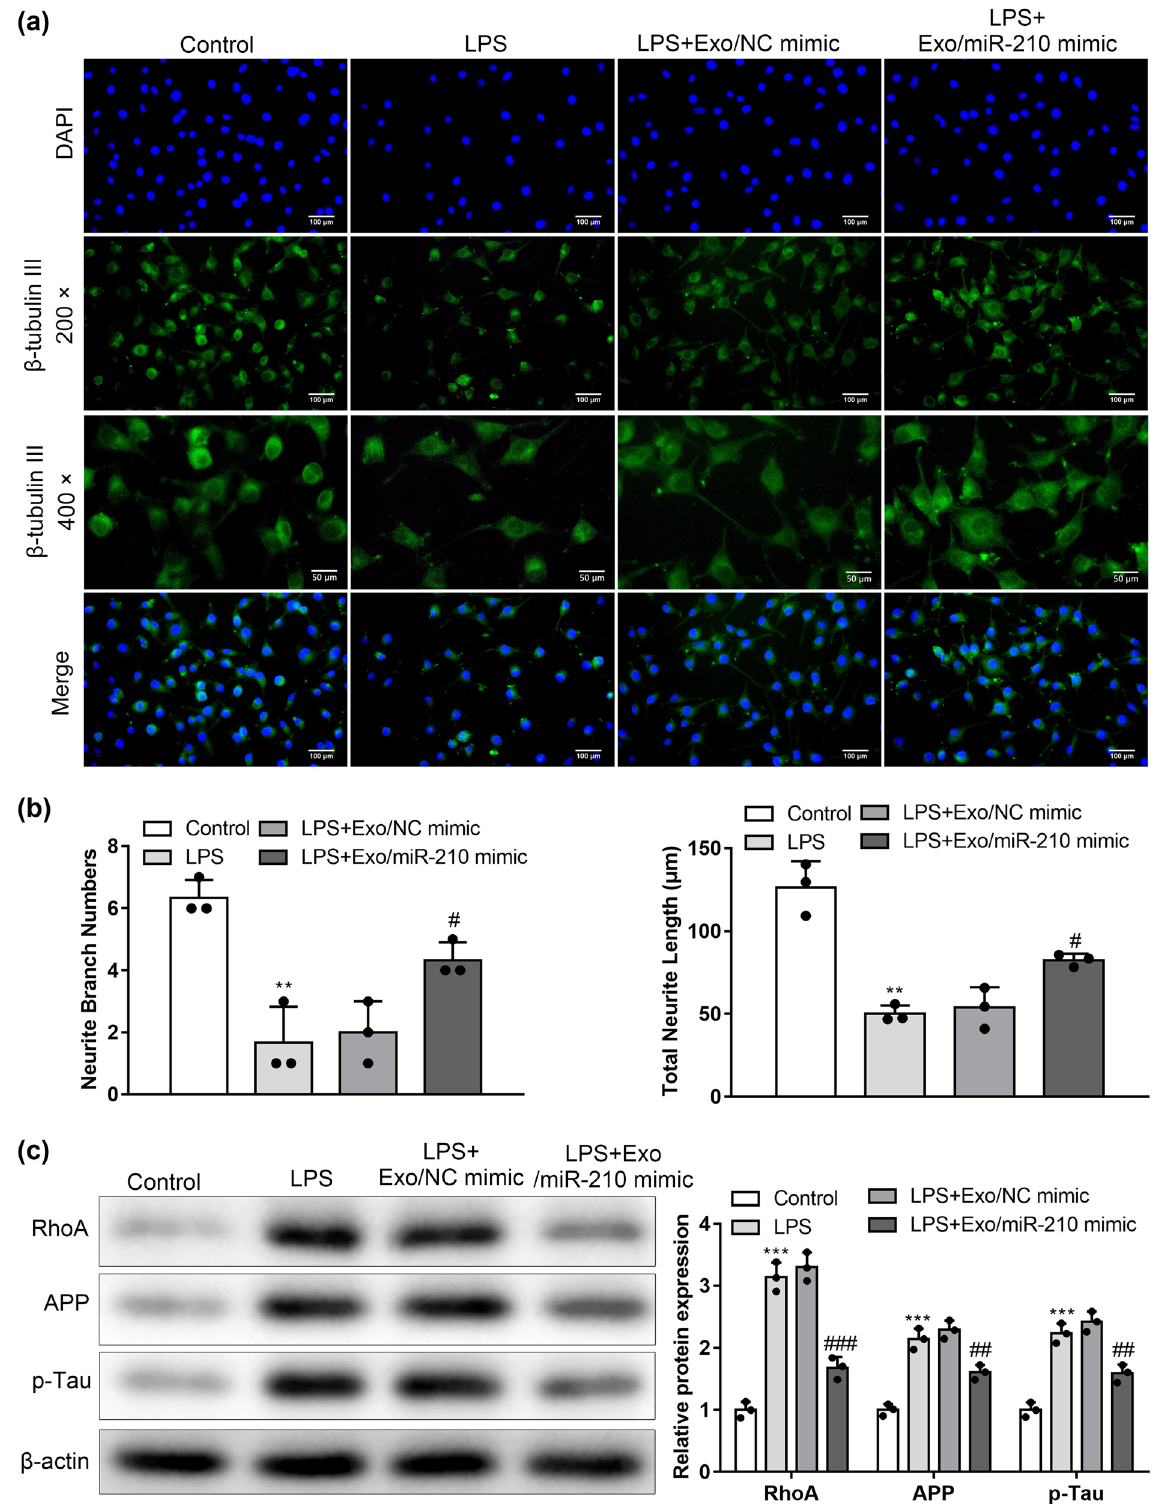
Figure 6: Exosomal miR - 210 promoted neurogenesis. ( a ) Representative images of cultured neuronal cells immunostained with anti - β - tubulin III antibody ( n = 3 ) . Scale bars: 50 and 100 μ m. ( b ) E ff ect of Exosomal miR - 210 on the axonal length and neurite branching in neuronal cells. Axonal length in di ff erent groups measured via imageJ. The average of three counts was calculated for the axonal length, and all the samples were analyzed over 30 cells per experiment ( n = 3 ) . ( c ) Detection of RhoA, APP, and p - Tau in the brain by western blot ( n = 3 ) . ** P < 0.01, *** P < 0.001 vs Control; # P < 0.05, ## P < 0.01, ### P < 0.001 vs LPS + Exo/NC